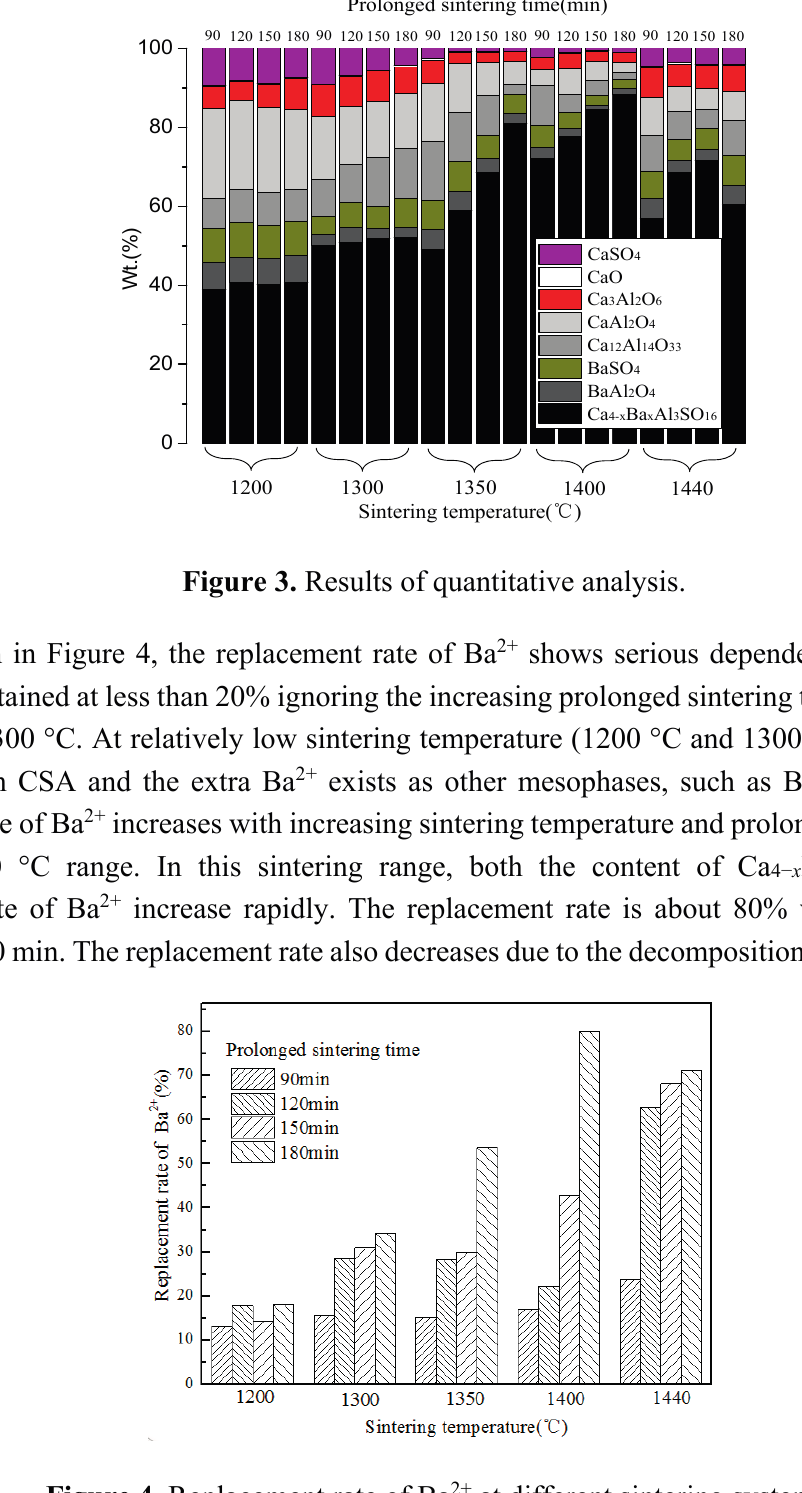
Figure 4. Replacement rate of Ba 2+ at different sintering